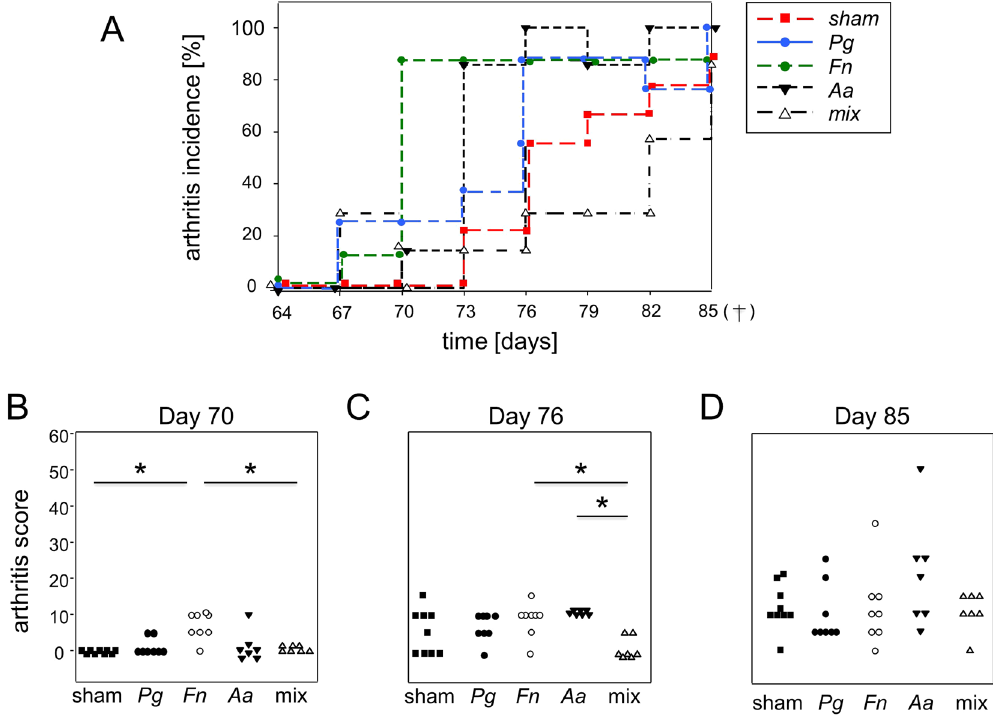
Figure 4. Oral inoculations with F. nucleatum or A. actinomycetemcomitans accelerated the onset and progression of subsequent CIA. ( A ) The plot shows the incidence of arthritis over the experimental period and compares mice orally inoculated with P. gingivalis (Pg), F. nucleatum (Fn), A. actinomycetemcomitans (Aa), the mix of all three species (mix) or sham treated controls (sham). ( B – D ) Display representative